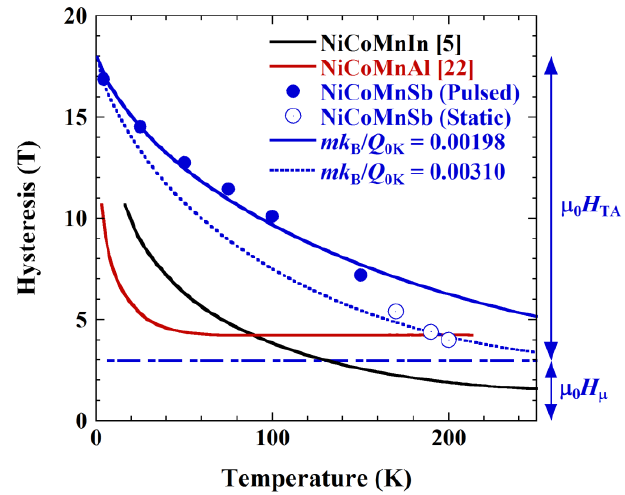
Figure 5. Temperature dependence of the magnetic field hysteresis, μ 0 H hys (≡ μ 0 H Af − μ 0 H Ms ), together with that for NiCoMnIn [5] and NiCoMnAl [22]. The solid line and dashed line are the fitting curves obtained by the Equation (2). The dot-dashed horizontal line stands for the athermal